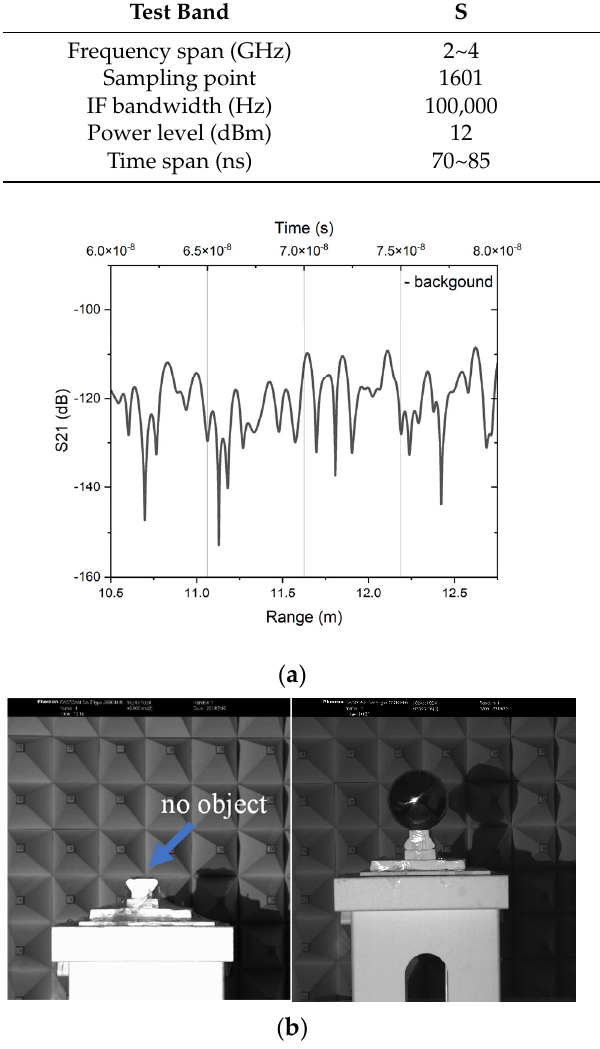
Figure 2. Example from the background environment: ( a ) data of the background, ( b ) a photo of no object on the foam holder, and an image of a large sphere on the foam holder. Table 1. Parameters of the network analyzer.